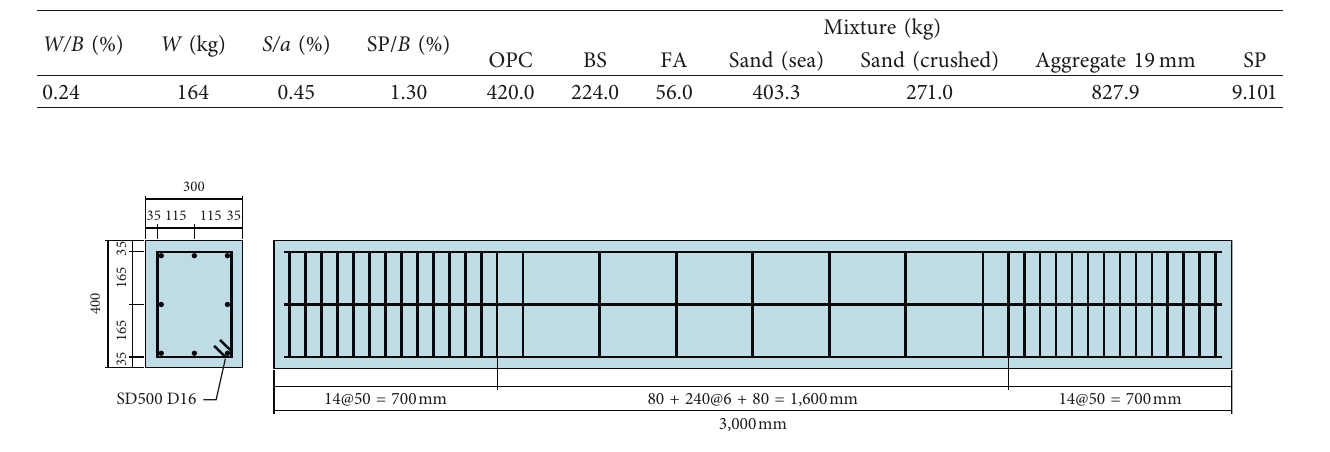
Table 1: Mix composition for 1m 3 of high-strength